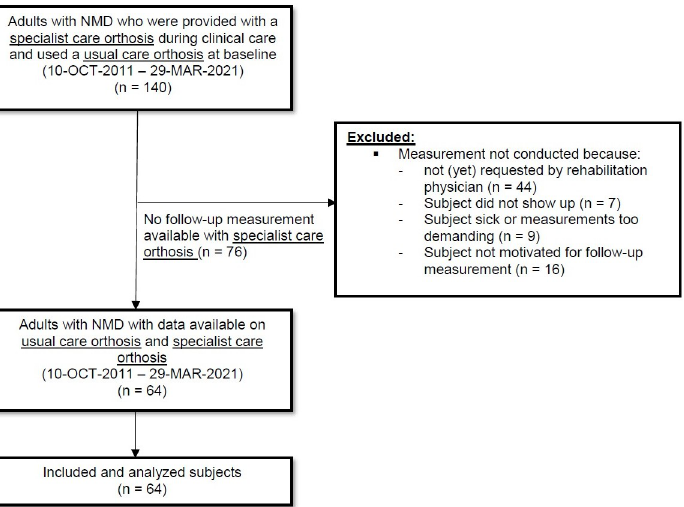
Fig 1. Flow diagram of subject selection from the orthotic laboratory database, including reasons for exclusion.